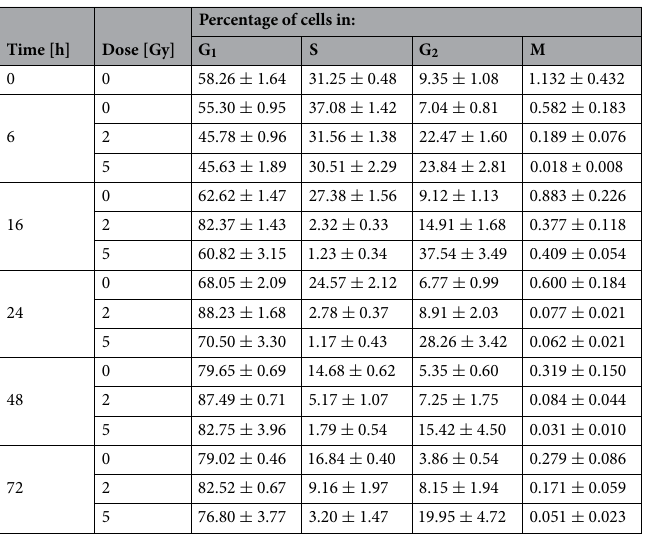
Table 1. Experimental percentages of cells in each cell-cycle phase for different doses (sham, 2 Gy, 5 Gy) at each time point.